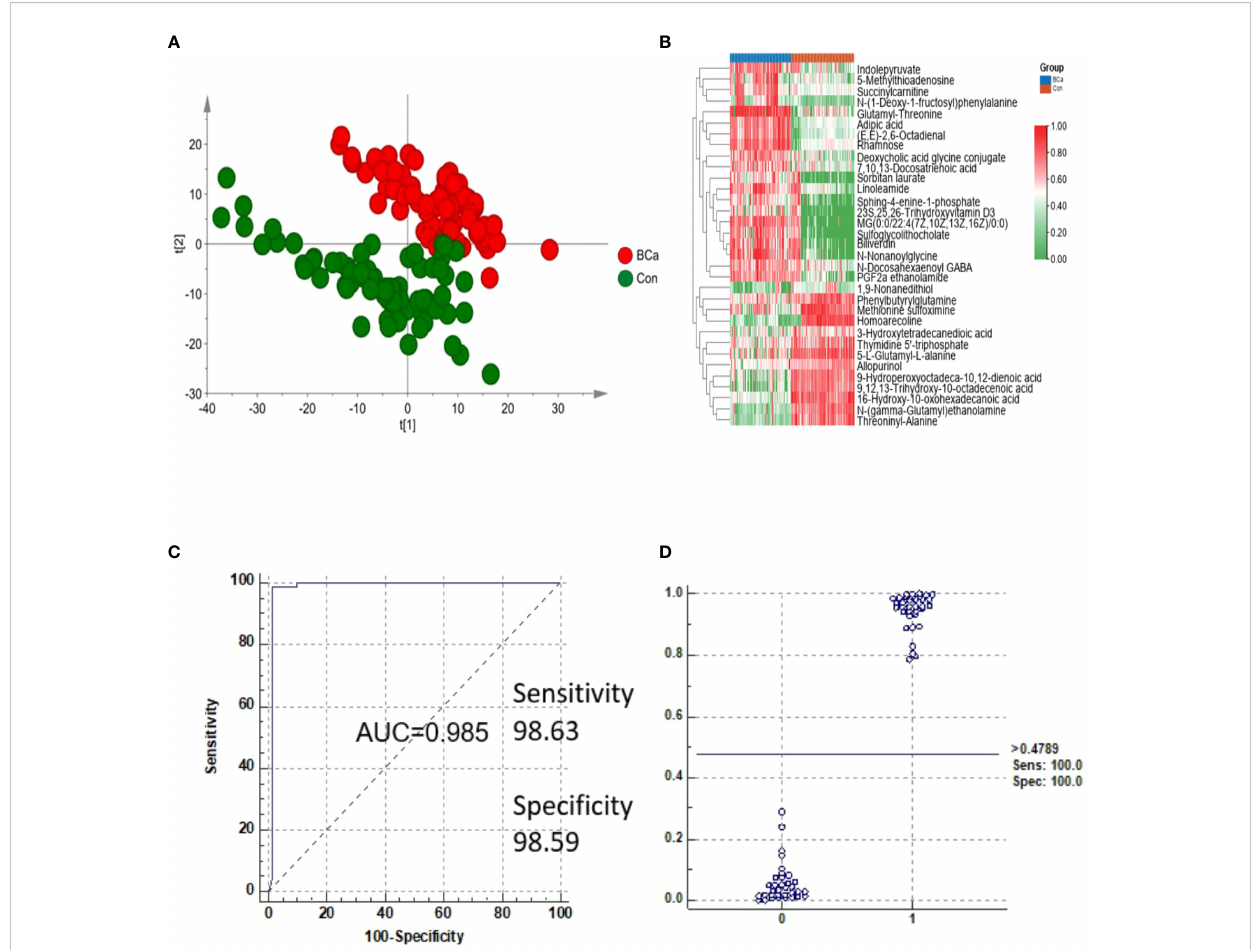
FIGURE 2 Analysis of metabolites in the NMIBC group vs . the control group. (A) Score plot of PCA of the NMIBC group and control group. (B) Relative intensity of differential metabolites in the NMIBC group and control group. (C) ROC plot of the NMIBC group and control group based on the discrimination degree. (D) External prediction of NMIBC by metabolite panels of 16-hydroxy-10-oxohexadecanoic acid, PGF2a ethanolamide, sulfoglycolithocholate, and